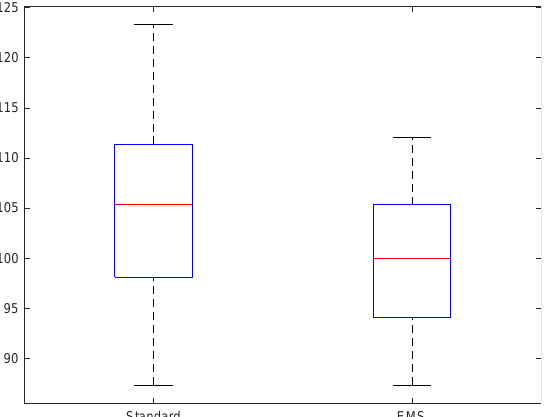
Figure 7. Boxplot of peak power requested to the main grid under standard ( left ) and optimal ( right ) EMS for the EV fleet.